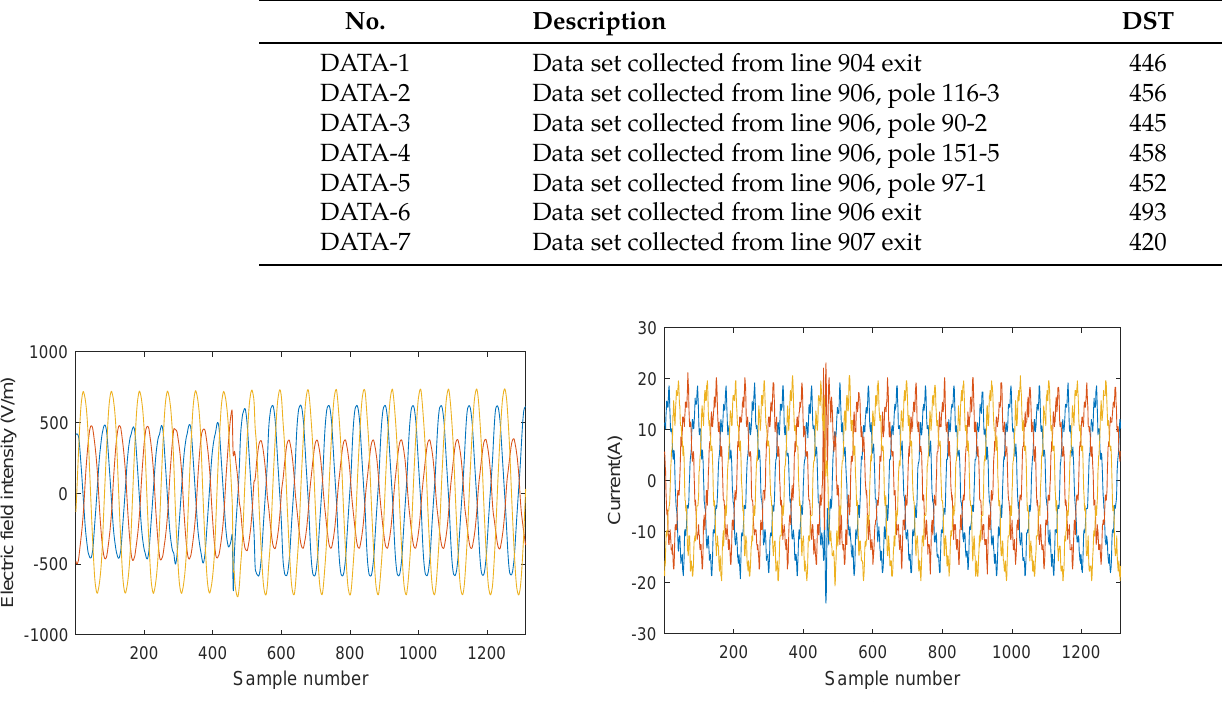
Table 1. The collected industrial data sets.